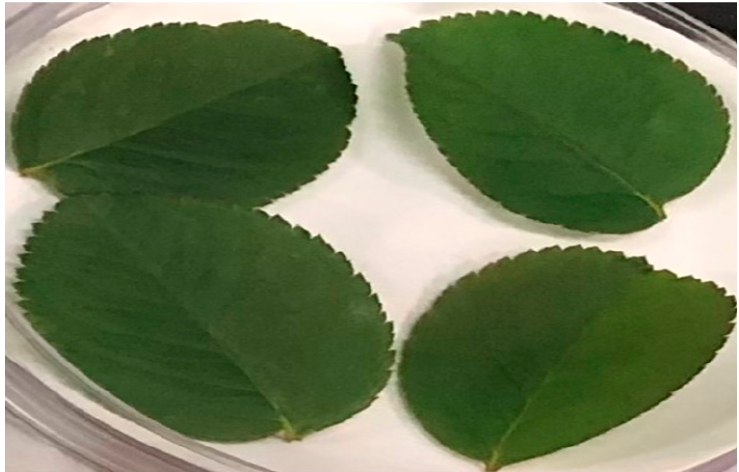
Figure 2. Rose leaves infected with black spot fungus.